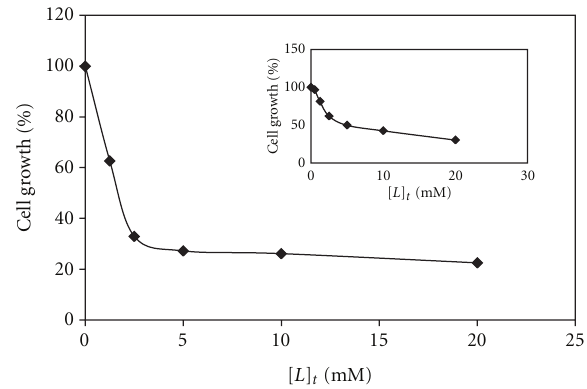
Figure 1: The growth suppression activity of the Pt(II) complex and the inset for Pd(II) complex on K562 cell line assessed using MTT assay as described in Section 2.1. The tumor cells were incubated with varying concentrations of the complexes for 24h.